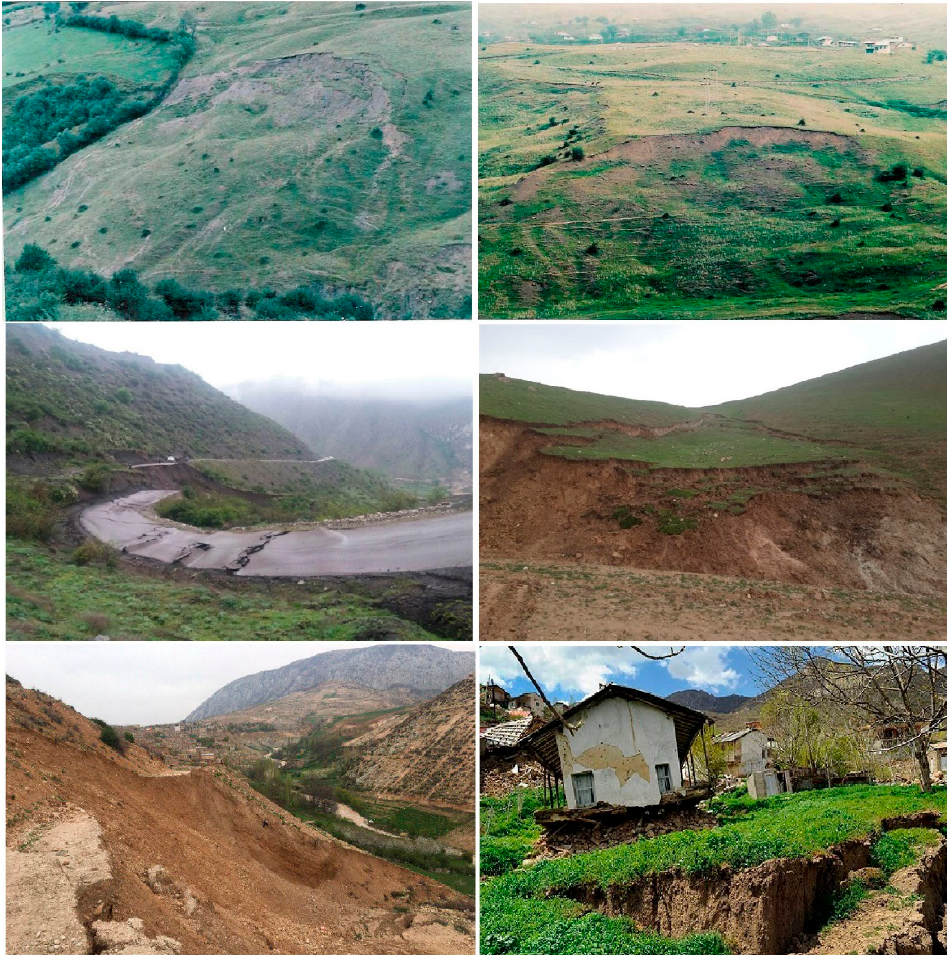
Figure 3. A view of several of historical landslides in the study area.